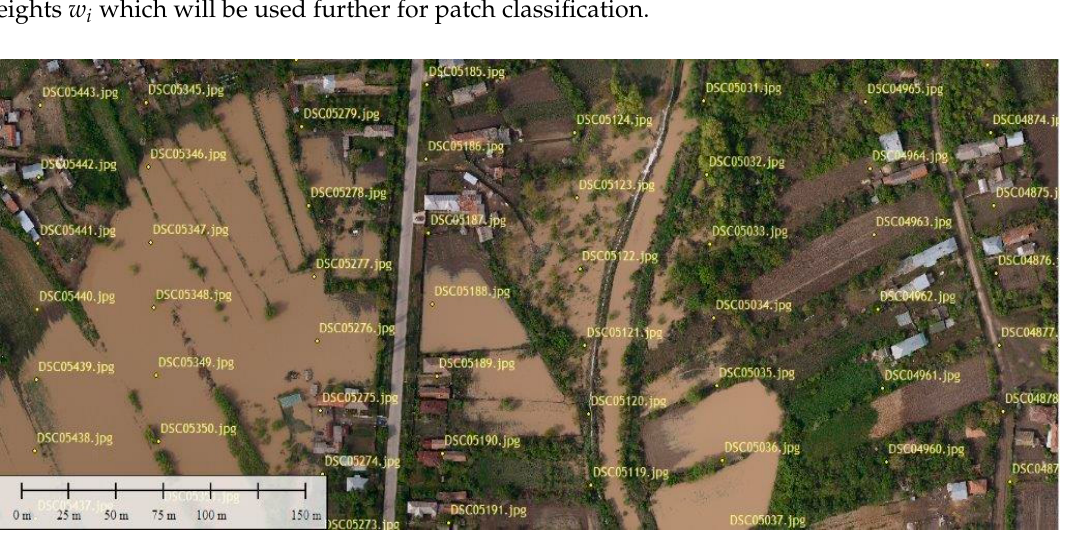
Figure 7. Image created from acquired images (with yellow ID) without overlapping or gaps. The image was generated with Agisoft Photoscan Professional Edition (www.agisoft.com).